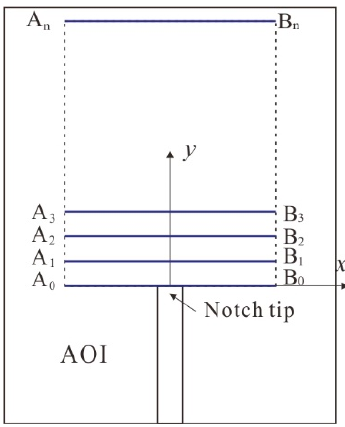
Figure 9. Computational grids for Specimen 0.3-3 in the AOI.